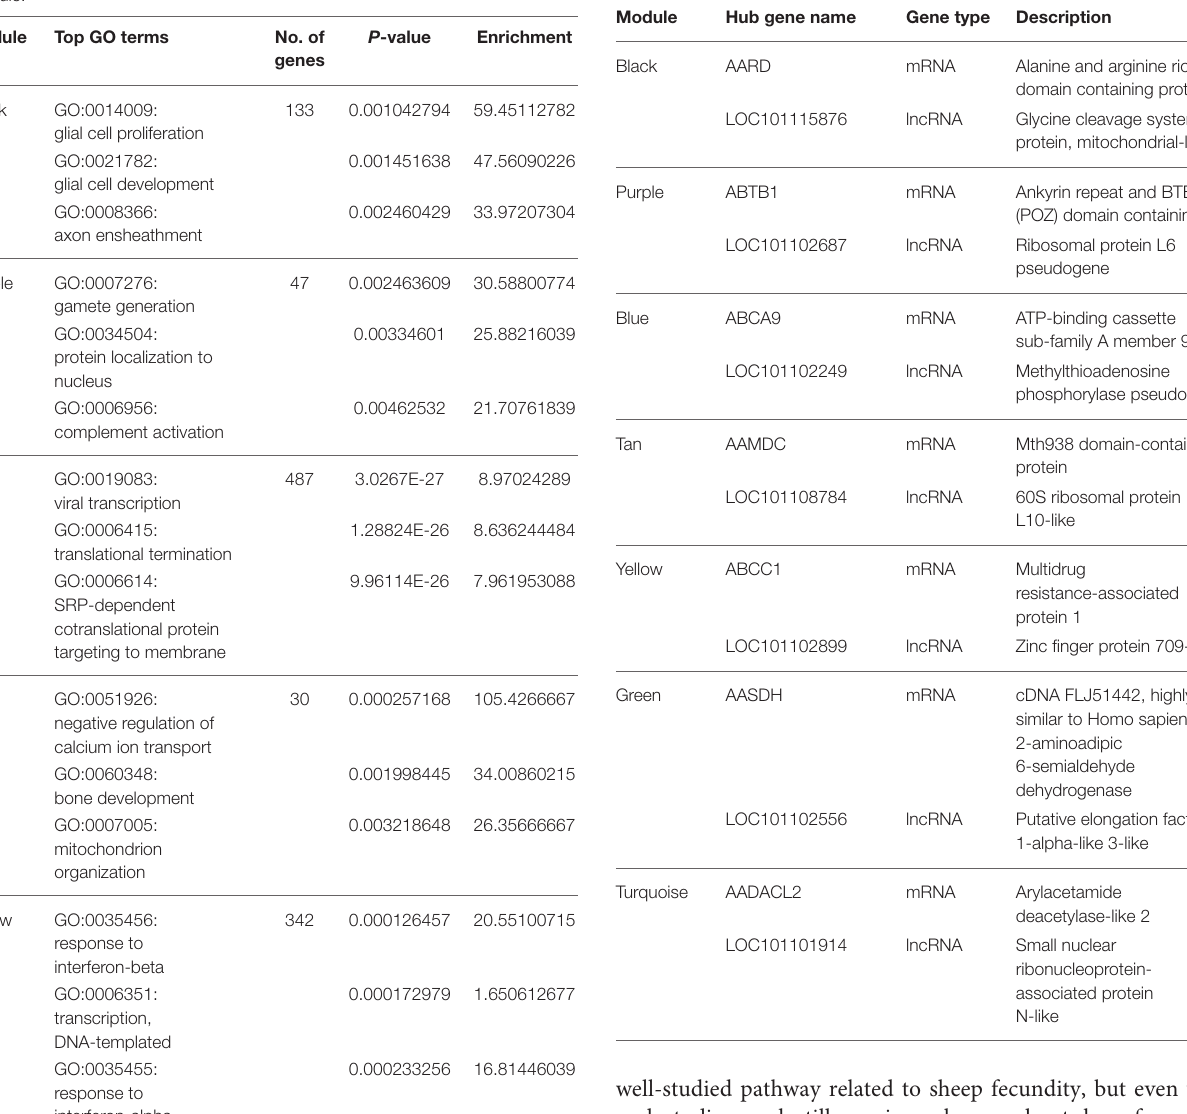
TABLE 2 | The top 3 GO terms of the methylated genes in each co-expression module.